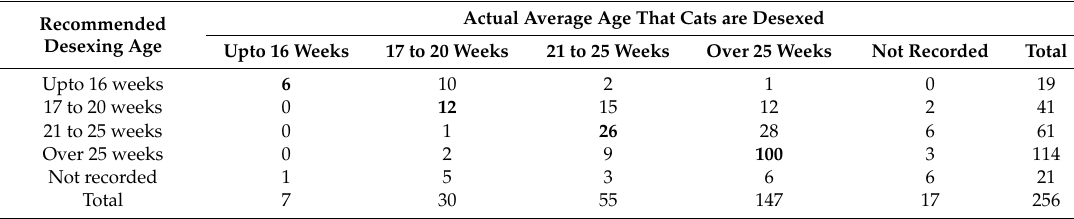
Table 4. Actual average ages that cats are desexed in relation to recommended desexing age for 256 Queensland veterinary practices (bolded values are numbers of practices where recommended and actual categories are the